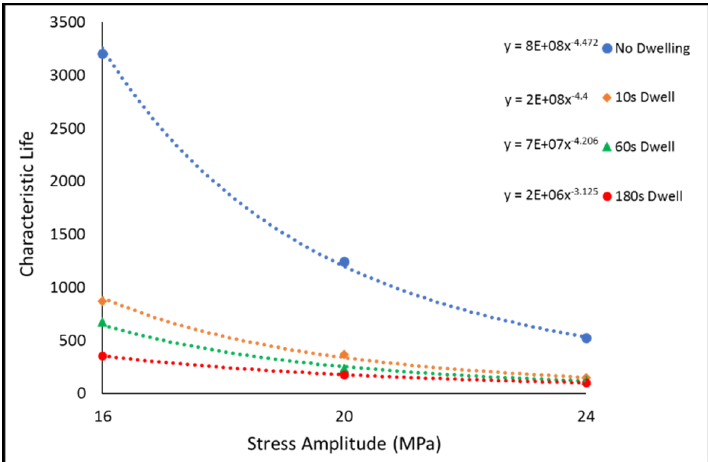
Figure 13. Characteristic life as a function of stress amplitude for SAC305 solder joints at various dwelling times.